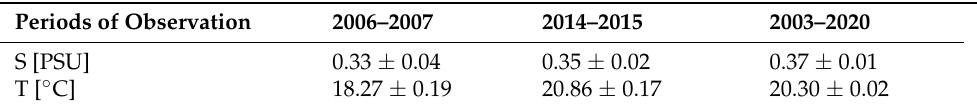
Table 1. Average water salinity and temperature in midsummer during the periods of construction of new port facilities (2006–2007; 2014–2015) and in their absence (2003–2005; 2008–2013; 2016–2020). S—water salinity; T—water temperature; ± standard